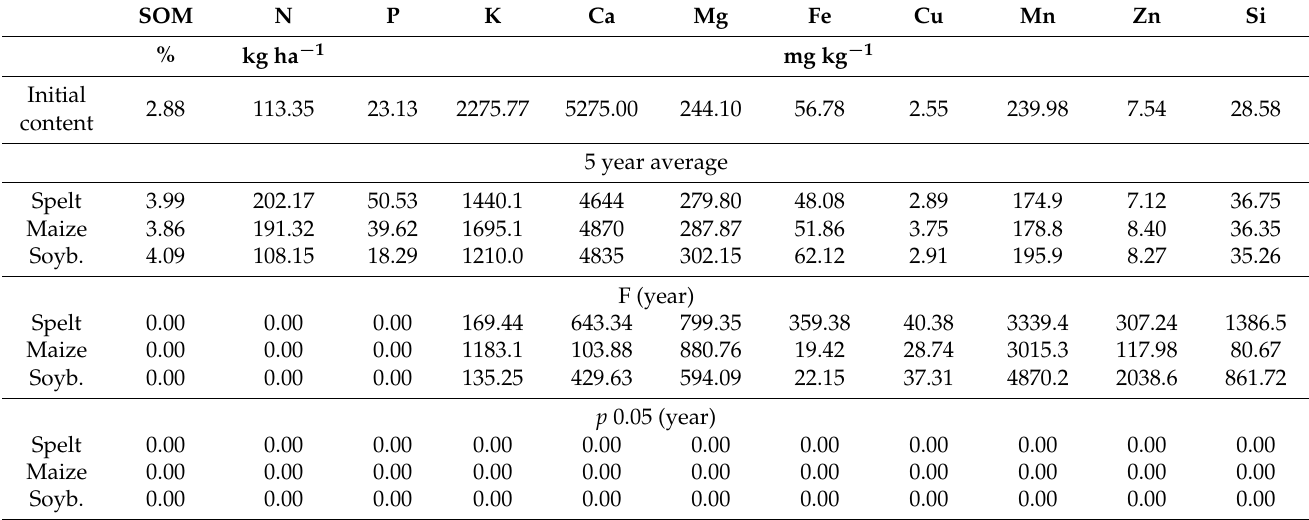
Table 3. Analysis of variance for the effect of the year (Y) on the variation of organic matter (OM), and status of available mineral elements in soil: N, P, K, Ca, Mg, Fe, Cu Mn, Zn, and Si in the soil of organically grown maize, spelt, and soybean.